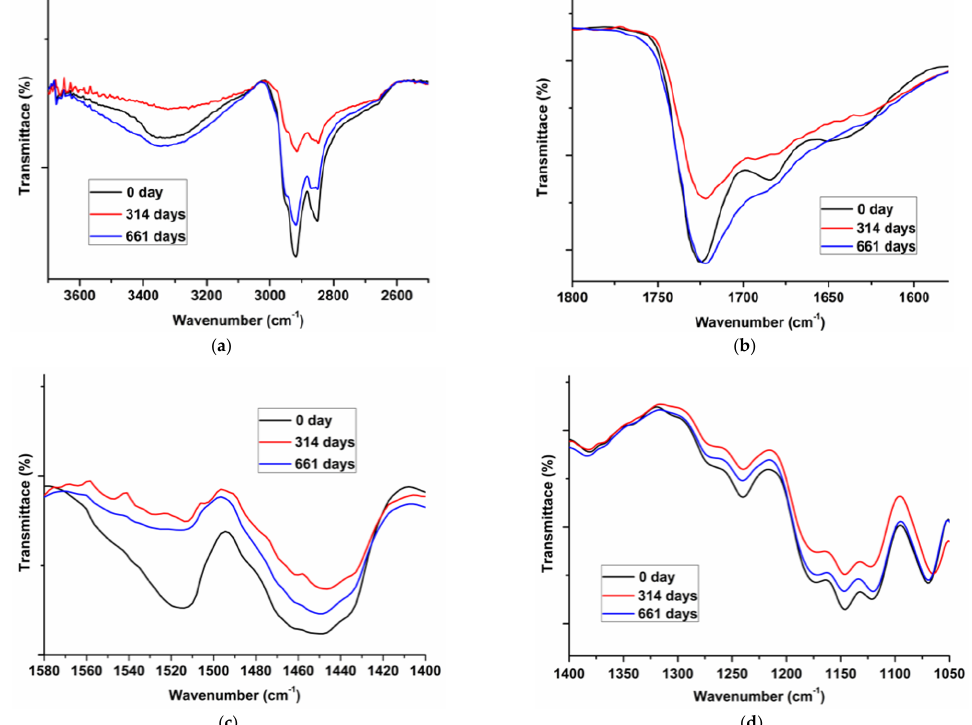
Figure 2. FTIR-ATR paint spectra of ( a ) mirror A1, ( b ) mirror C2, and ( c ) mirror D2, exposed on both outdoor testing sites (Seaside and desert sites).